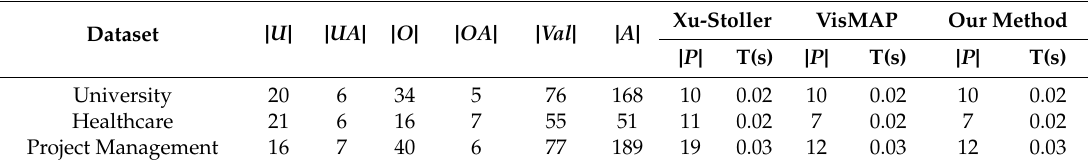
Table 17. Descriptions of real